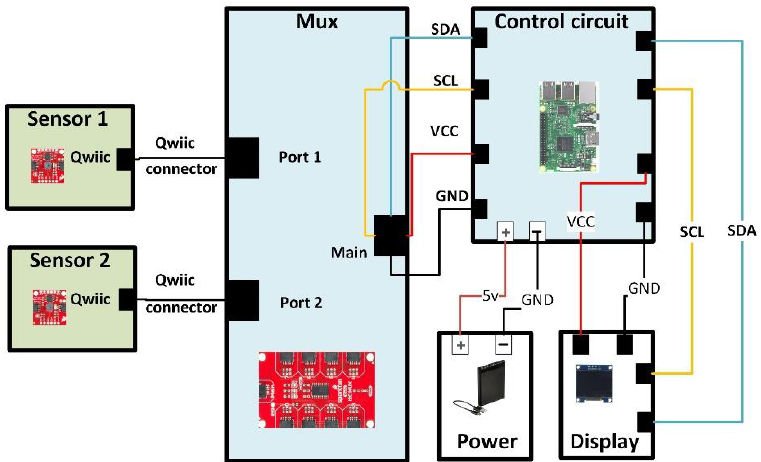
(b) ( c ) Figure 1. ( a ) The leaf is placed in between the clips; Sensor1 and Sensor2 touch the leaf during scanning. ( b ) Back view of the graphical set-up. Components of the sample device ( c )—multiplexer